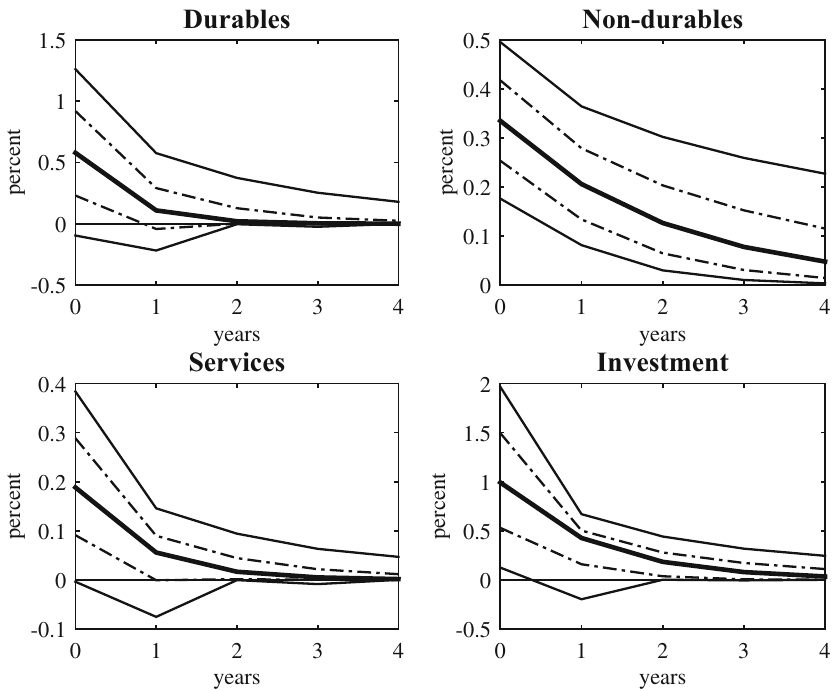
Fig. 3 Dynamic response of aggregate expenditure components to transfers shocks